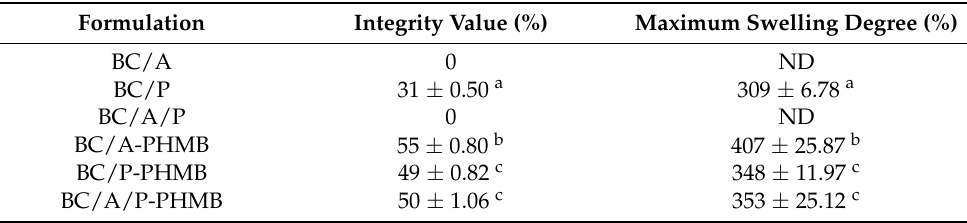
Table 3. Integrity value and maximum swelling degree of hydrogels containing